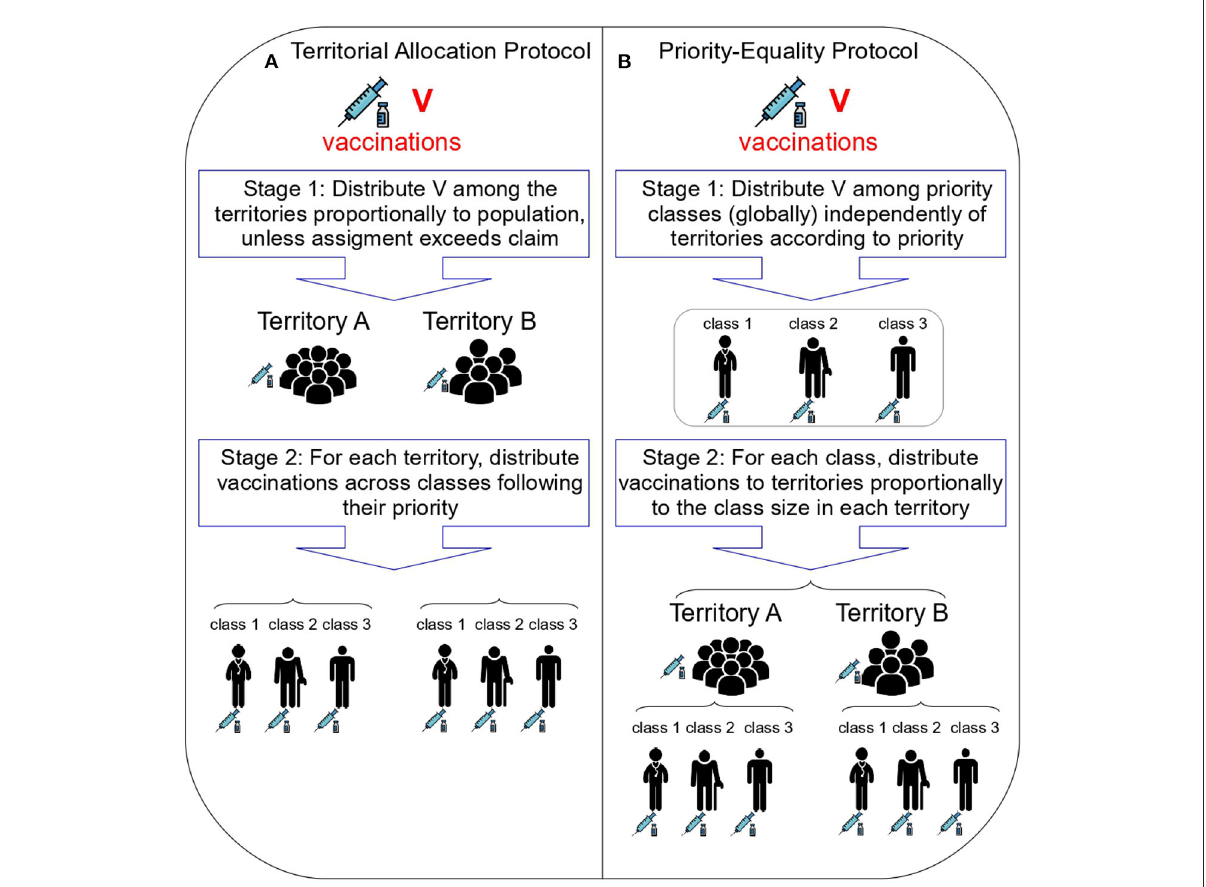
FIGURE2 The Territorial Allocation and Priority-Equality protocols. (A) (left) shows the two stages of the Territorial Allocation protocol, which captures the essential features of those actually used for COVID-19. (B) (right) shows the two stages of the Priority-Equality protocol, which we identify in this work as the only one satisfying fundamental ethical principles. Icons made by Freepik from Flaticon